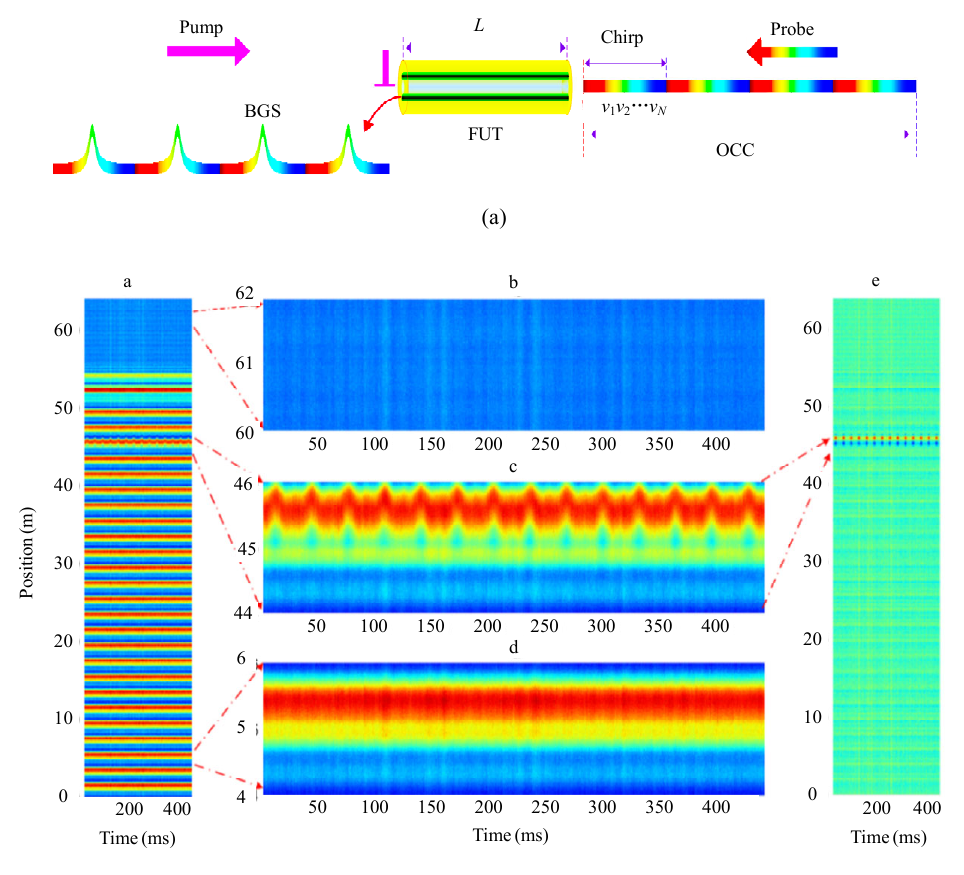
Fig. 12 OCC-BOTDA: (a) operation principle and (b) dynamic measurement